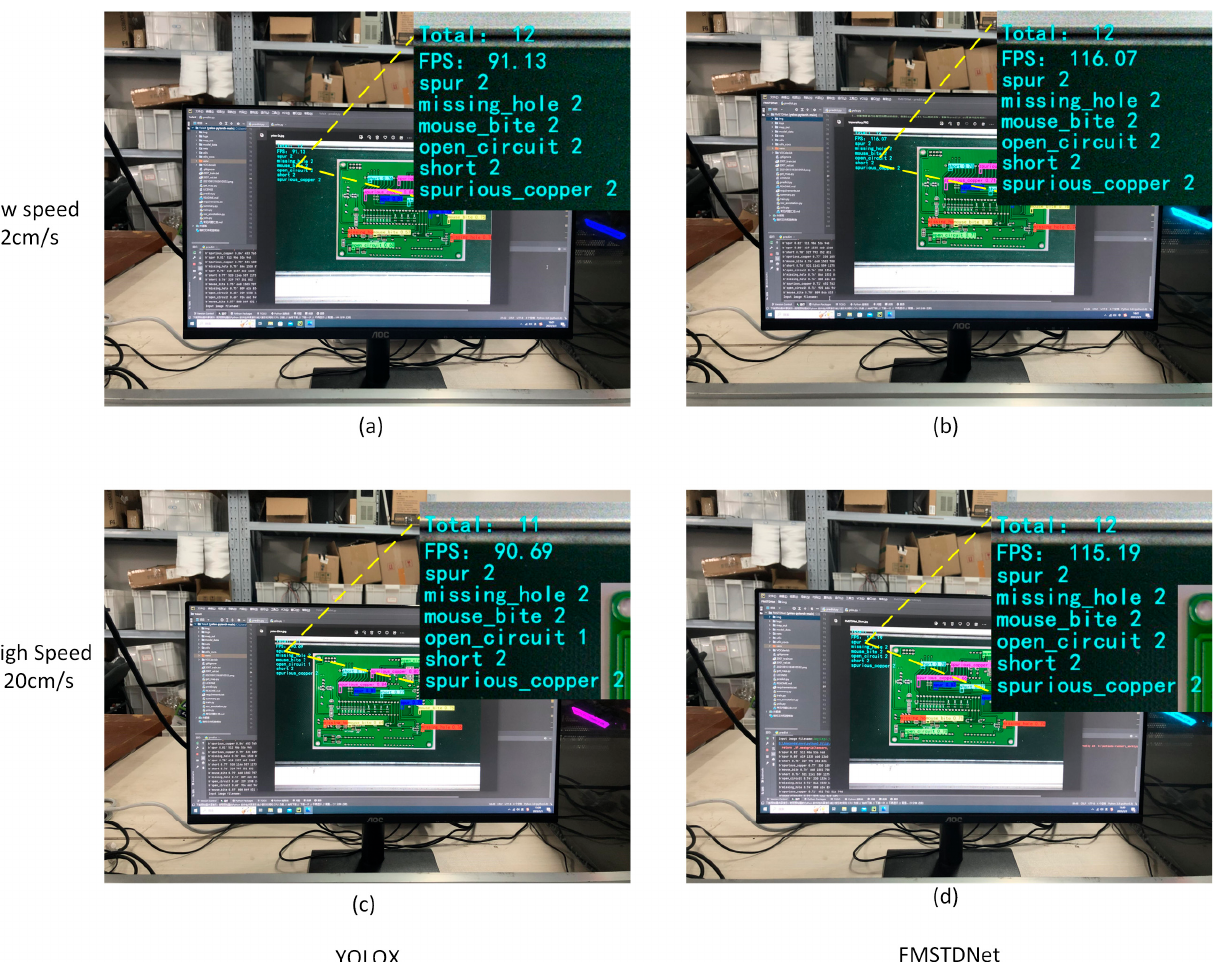
Figure 6. Comparison of YOLOX and FM-STDNet detection results. ( a ) Detection results of YOLOX model at 2m/s moving speed; ( b ) Detection results of FMSTDNet model at 20m/s moving speed; ( c ) Detection results of YOLOX model at 2m/s moving speed; ( d ) Detection results of FMSTDNet model at 20m/s moving speed.